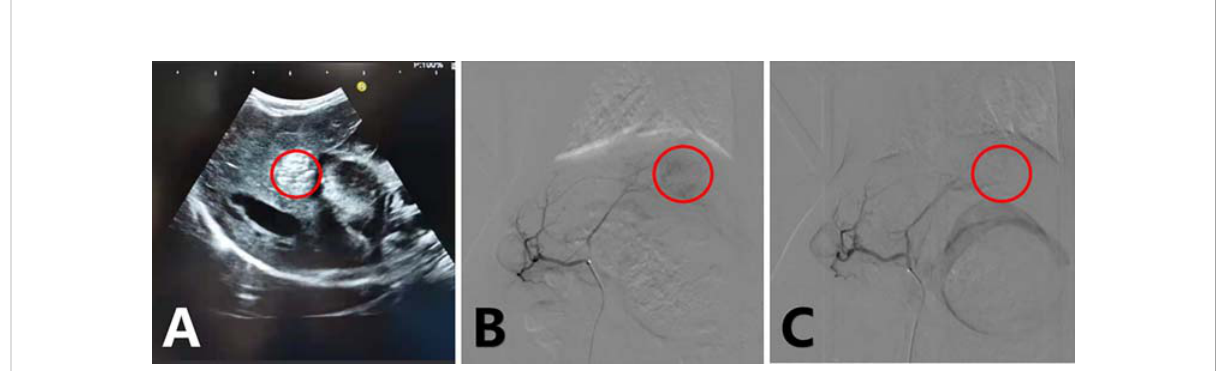
FIGURE 2 Ultrasound-guided tumor implantation, hyperechoic coda in the liver (A) ; arterial angiography of a rabbit VX2 liver tumor before treatment (B) and immediately after treatment (C) with epirubicin-loaded CB. Tumor staining disappeared after embolization.